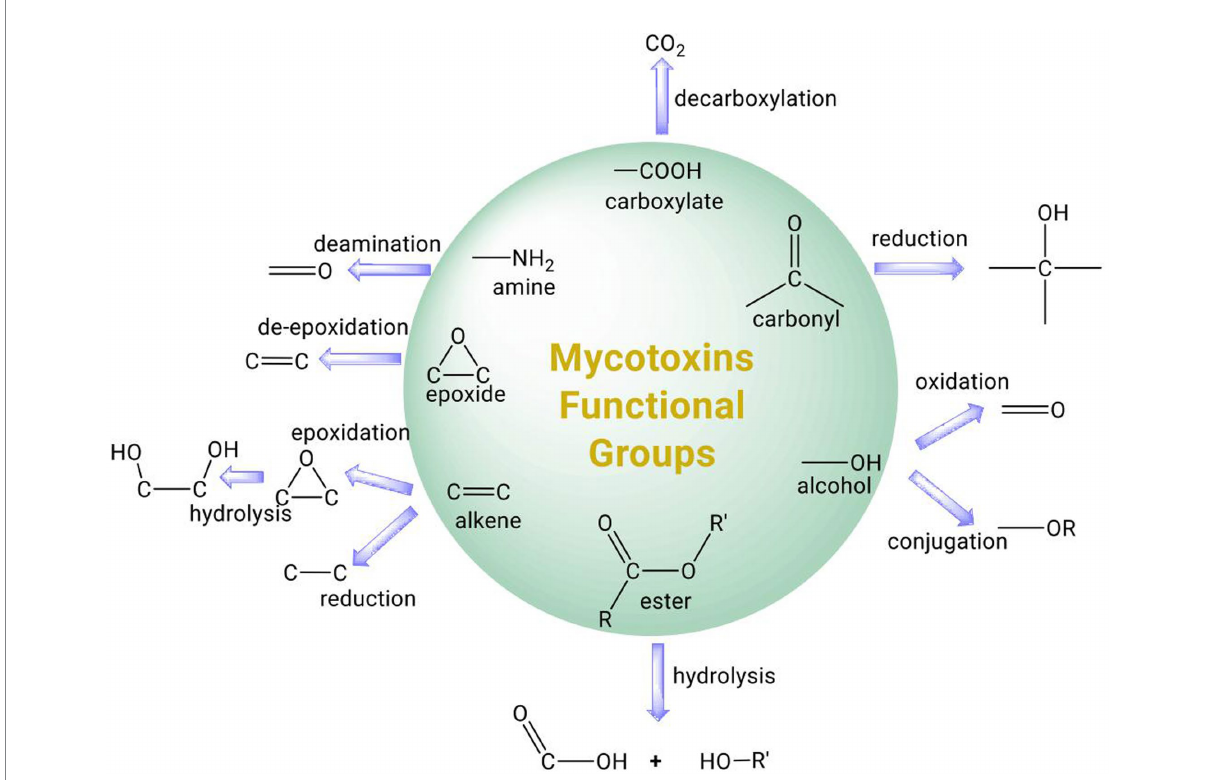
FIGURE 1 Summary of common functional groups of mycotoxins (circle) and their possible transformation by microbial